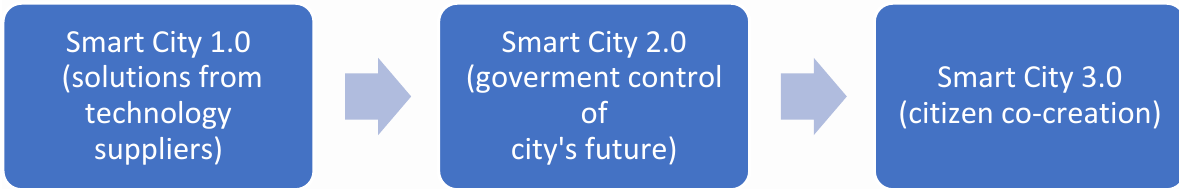
Figure 2. Smart city concepts. Source: adapted from Qonita, M. and Giyarsih, S., 2022 [22].